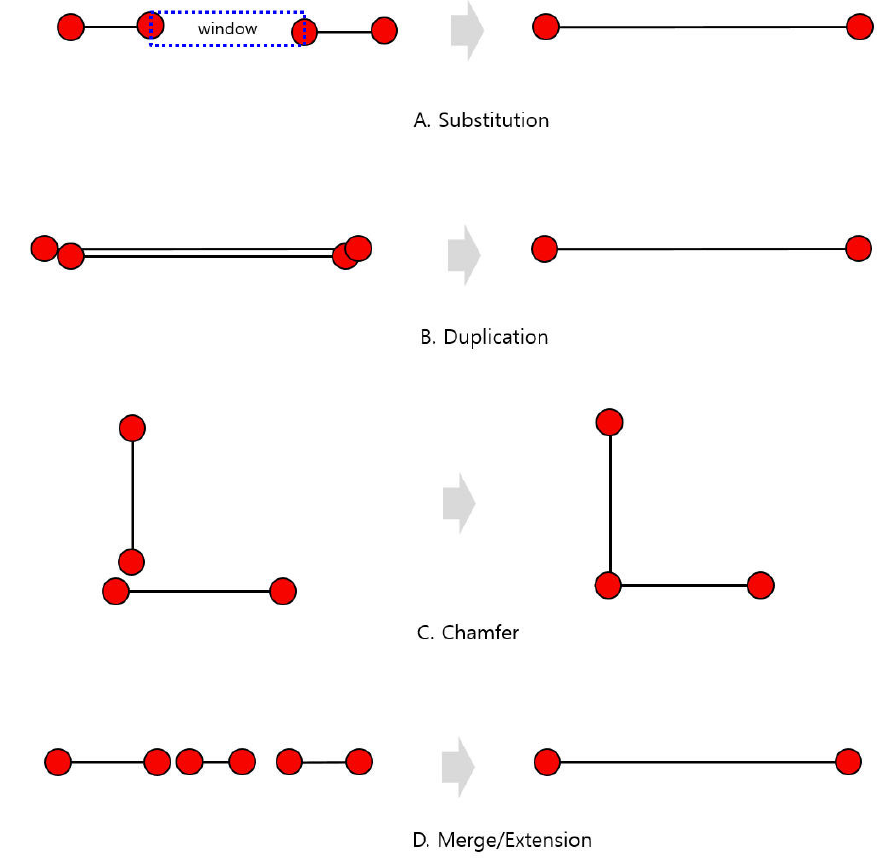
Figure 7. Node/Edge generation